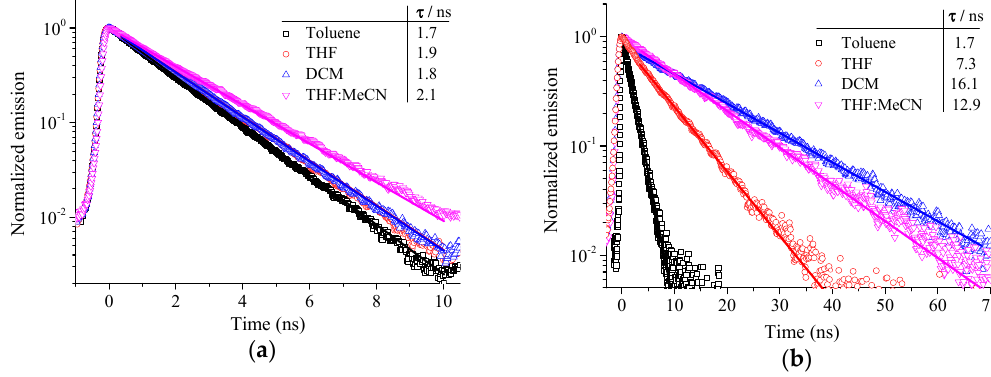
Figure 4. PL decay (open symbols) of D1 ( a ) and D2 ( b ) tracked from 425–445 nm and 490–510 nm, respectively. Solid lines represent fits with a monoexponential decay function.